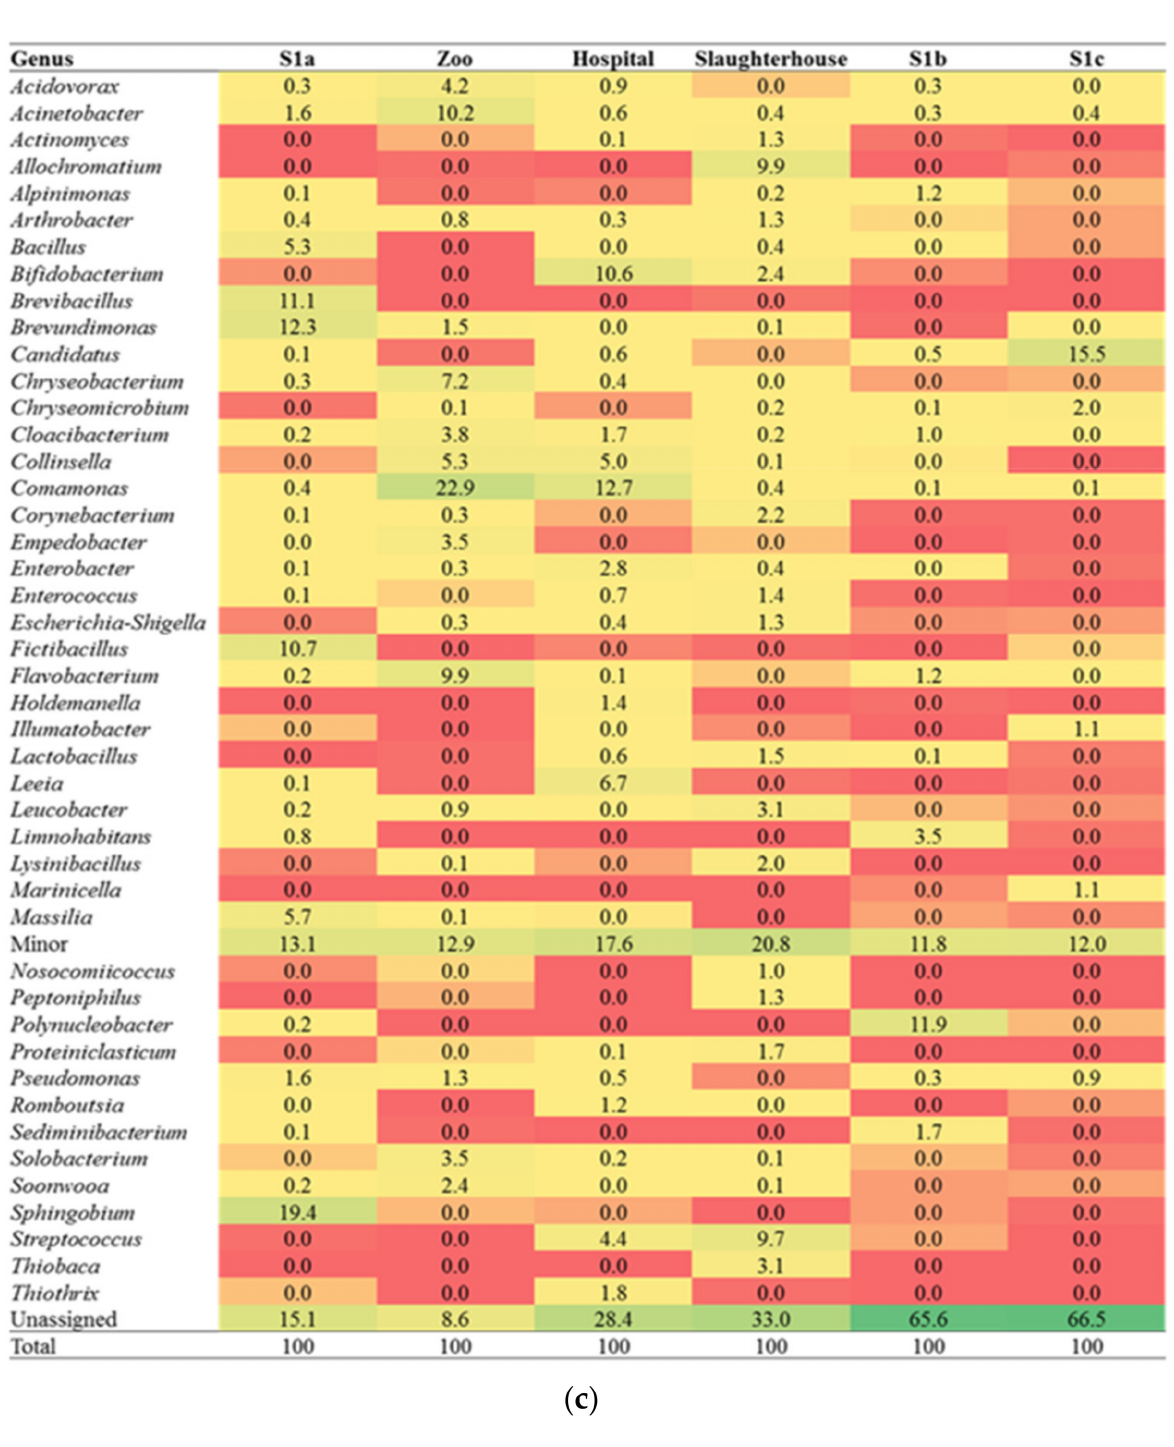
Figure 3. Microbial community structure by metagenomics approach at ( a ) phylum, ( b ) class, and ( c ) genus level. Only classified bacterial genera with >1% were displayed. The genera with <1% were grouped as minor, while those that could not be classified were grouped as